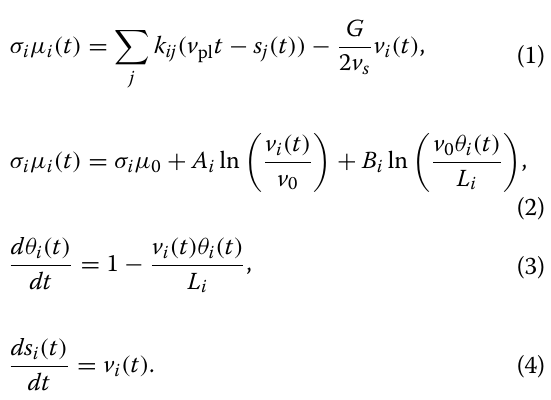
Fig. 2 Fault models. Thick rectangle is the modeled region, which is divided into 10 km Tokachi-oki and the Kushiro-oki asperities, respectively. The entire fault is divided into 9 and 71 regions in a model 1 and b model 2, respectively. Frictional parameters are assumed to be uniform within each region. Model 1 is used in the numerical experiments, while model 2 in the application to real